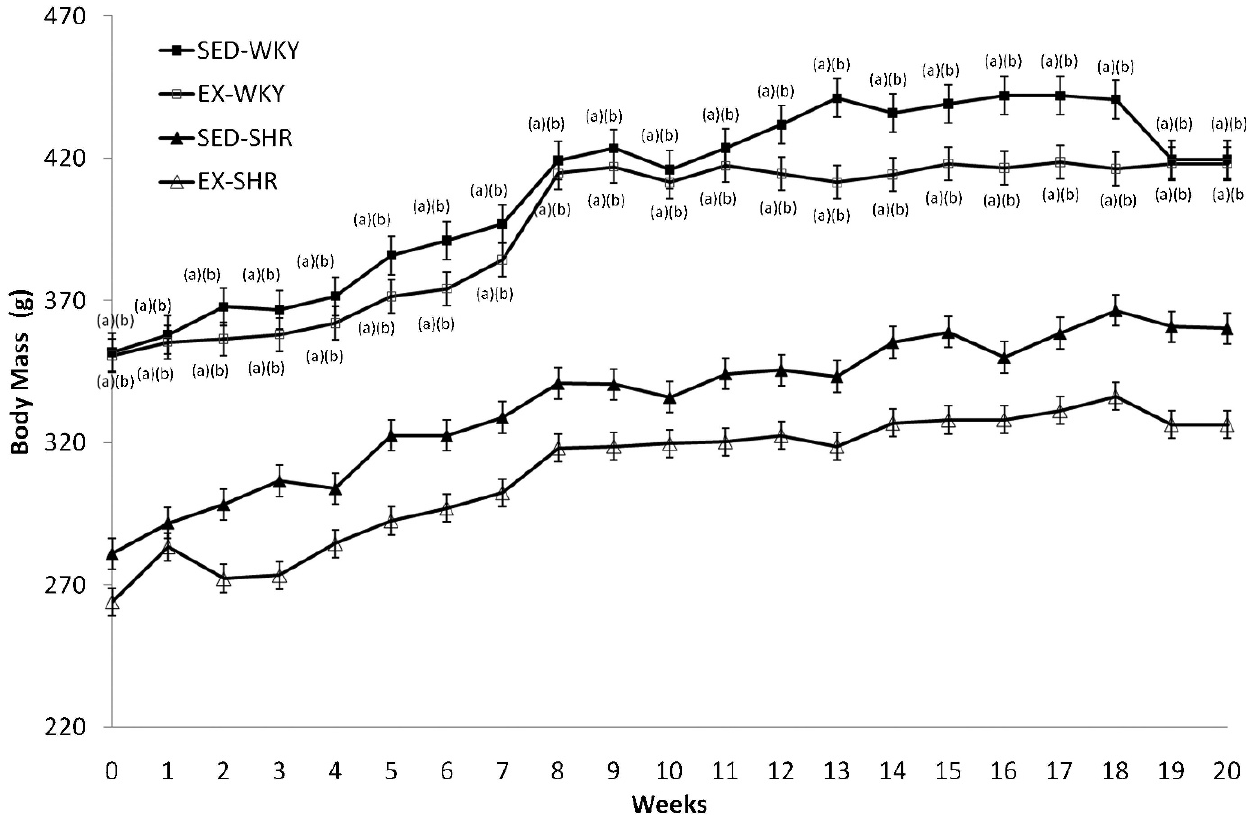
Figure 2 - Body mass before and during twenty weeks of treatment. Abbreviations: EX, exercised; SHR, spontaneously hypertensive rats; SED, sedentary; WKY, Wistar-Kyoto rats. One-way ANOVA and post-hoc Tukey’s test; P , 0.001 for (a) vs. SED-WKY, (b) vs.